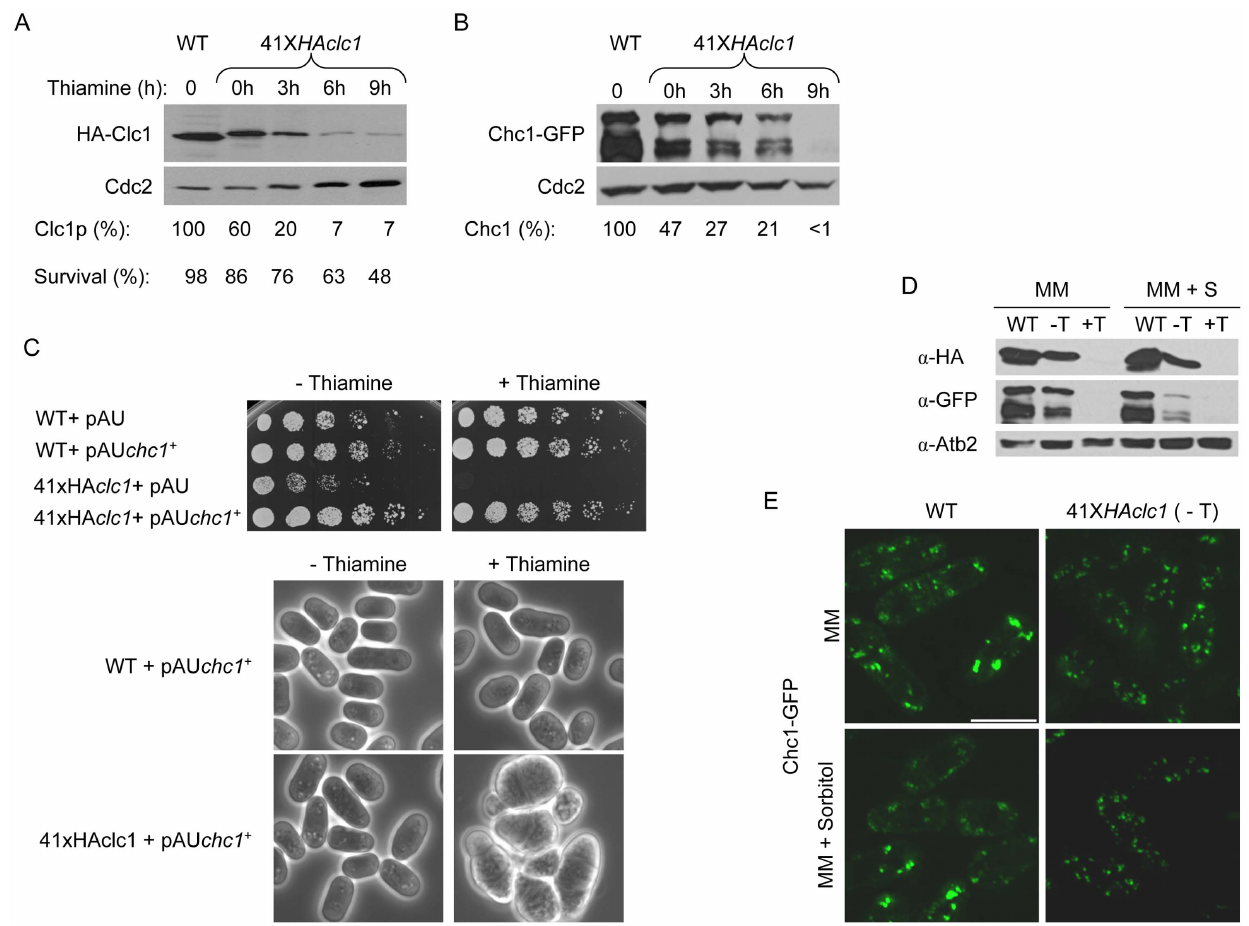
Figure 3. Characterization of clathrin in the 41X HAclc1 mutant. A. Western blot of extracts from cells in which the clc1 + gene, fused to the HA epitope, was driven from its native promoter or from the 41X nmt1 + promoter and were incubated in the presence of thiamine (repressing conditions) for the indicated hours (h). The amount of Clc1p was calculated considering the amount of protein produced from the clc1 + promoter as 100%. To calculate cell survival, samples were withdrawn from the culture at the indicated times; 600 cells were plated onto YES with sorbitol, and the number of colony-forming units was scored. The experiment was performed three times. The data correspond to the mean. B. The same as in A but the cells carried a Chc1-GFP fusion protein. C. Upper panel, 3 6 10 4 cells and serial 1:4 dilutions from the indicated strains were inoculated on minimal medium minus uracil, without and with thiamine, and incubated for three days at 28 u C. Lower panes, cells from the indicated strains and conditions were taken from the plates and photographed using a conventional phase-contrast microscope. D. Western blot of extracts from the wild-type strain and the 41X HAclc1 mutant bearing HA-Clc1 and Chc1-GFP fusion proteins. Cells were grown in minimal medium and minimal medium with sorbitol in the absence ( 2 T) and the presence ( + T) of thiamine for 15 hours. a -Atb2 (tubulin) was used as a loading control. E. Micrographs of wild-type and 41X HAclc1 cells bearing Chc1-GFP grown in minimal medium and minimal medium with sorbitol in the absence of thiamine. Micrographs (projections) were taken with a DeltaVision deconvolution microscope. Bar, 10 m